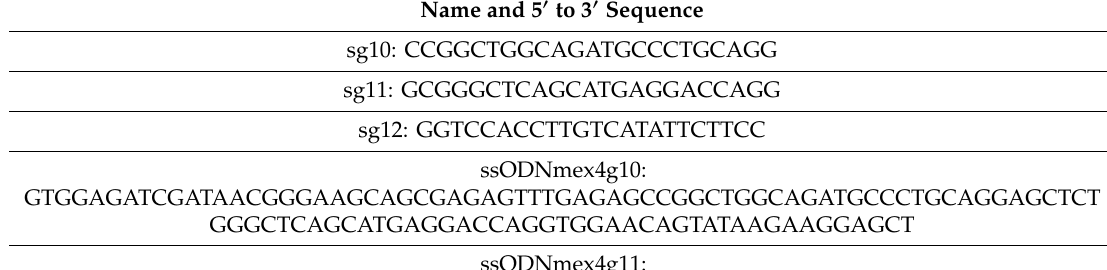
Table 2. DNA sequences used in this work. Name and 5 (cid:48) to 3 (cid:48)